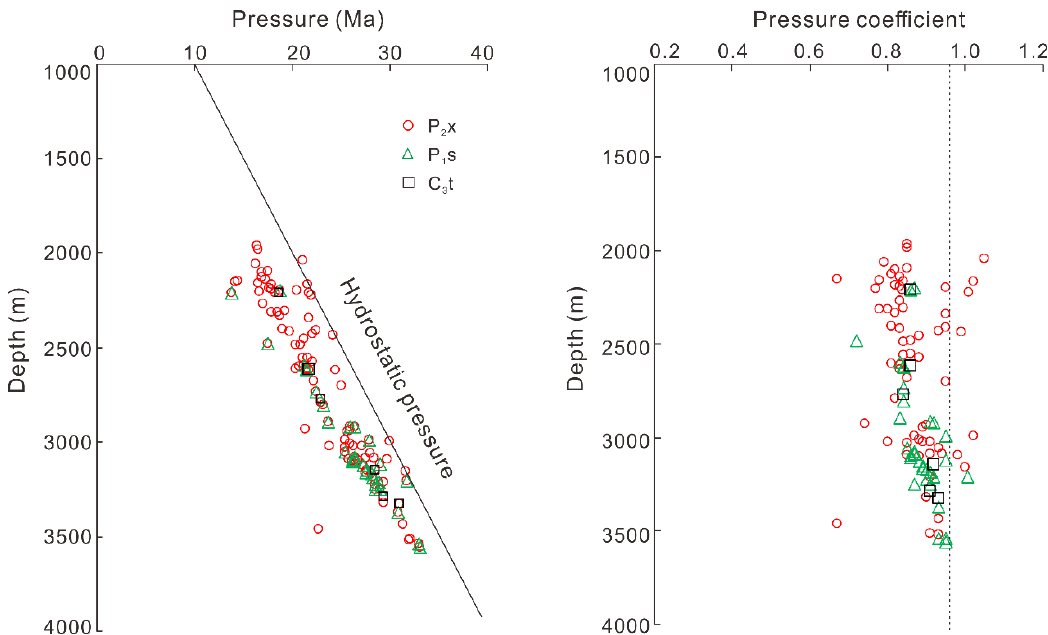
Figure 8. The current pressures and pressure coefficients of the Upper Paleozoic sandstones in the Hangjinqi area.